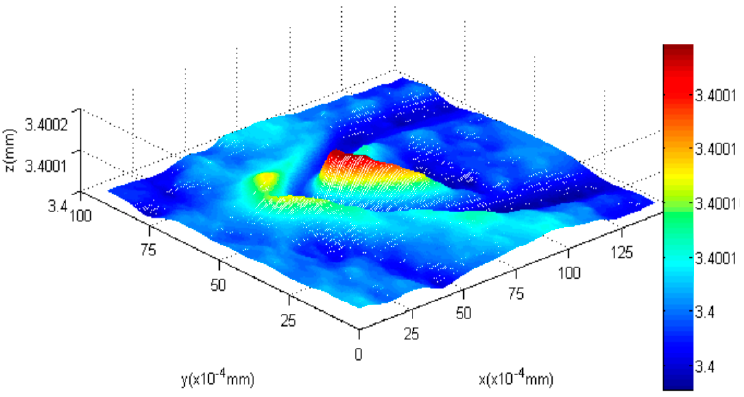
Figure 12. The reconstructed 3D shape of the cantilever.